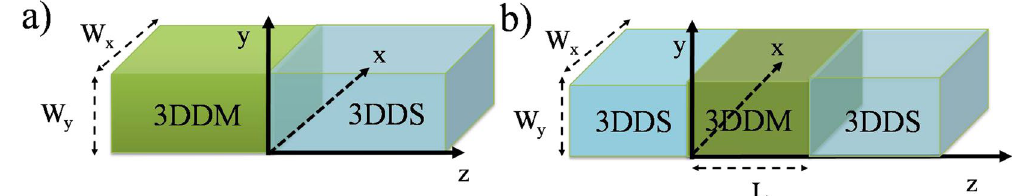
Figure 1. ( a ) Schematic illustration of 3DDM|3DDS junction ( m | Δ 5 ). We assume a 3DDM can be superconductor by proximity effect. ( b ) The Josephson junction of 3DDS|3DDM|3DDS ( Δ 5 | m | Δ 5